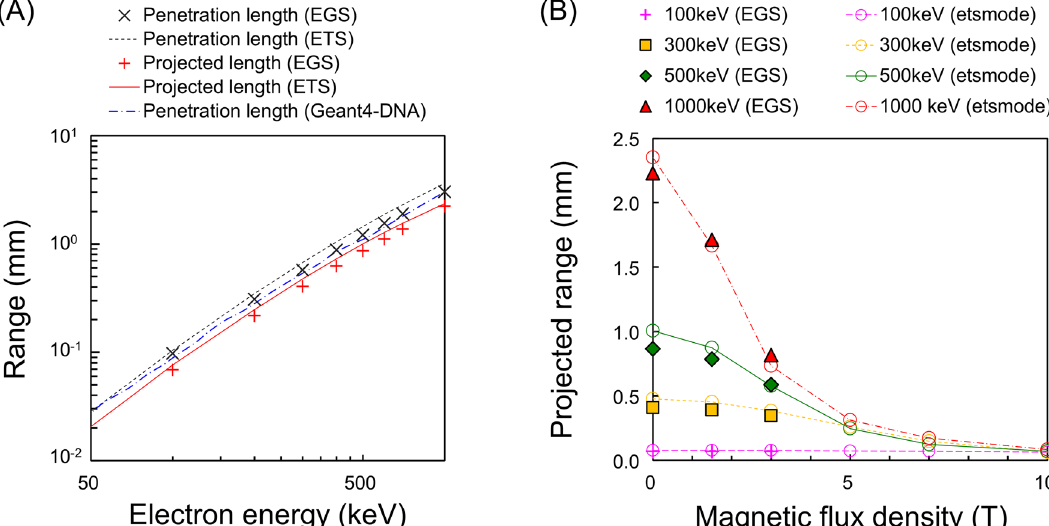
Figure 2. Electron ranges in SMFs calculated by etsmode and EGS. ( A ) shows the penetration length and projected range in the absence of a SMF ( B = 0.0 T) and ( B ) shows the projected range in the presence of various SMF strengths ( B = 0.0–10.0 T). The simulation results by etsmode and EGS are in good agreement with each other and other simulation results by the Geant4-DNA toolkit 30 . As shown in Fig. 2B, the projected range of high-energy electrons is largely affected by the SMF